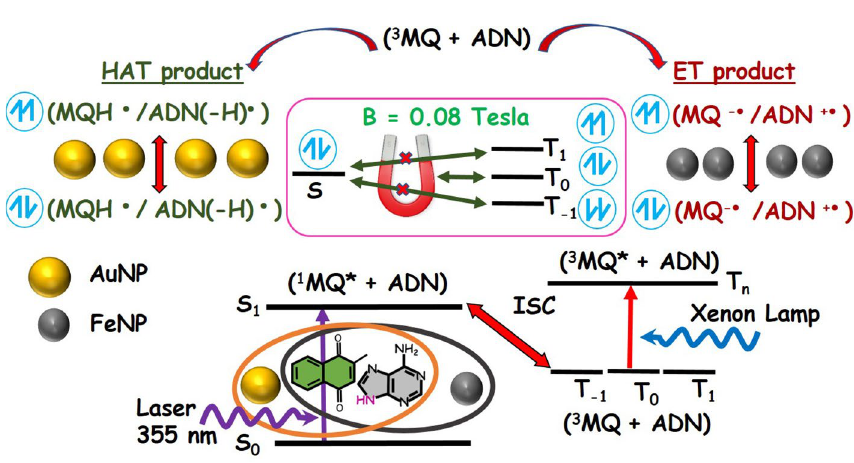
Figure 6. Plausible reaction pathways showing the various excited state photophysical and photochemical processes (ISC, ET and HAT) in the presence of 0.08 T magnetic field. The box in the middle shows the splitting of the non-degenerate triplet energy levels in presence of the field. The orange ellipsoid indicates the reaction scheme in presence of AuNP, while the dark one reflects it for the